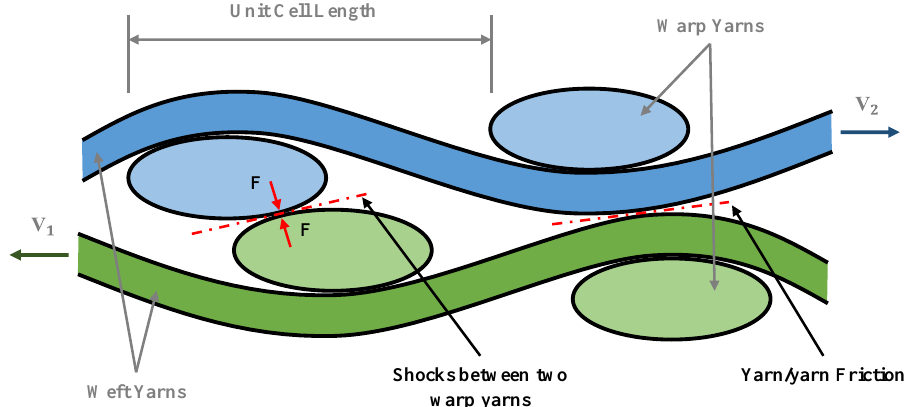
Figure 21. Two different friction behaviors between yarns.